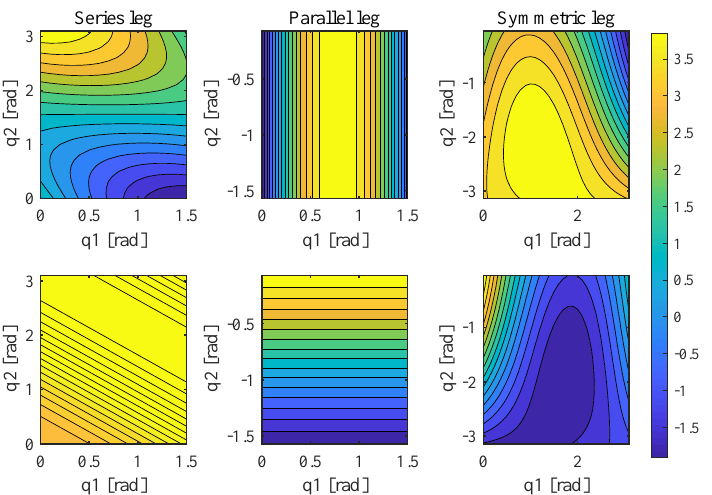
Figure 3. The proprioceptive sensing of three kinds of leg topology. The first and second line are joint 1 and joint 2 of the three types of leg, respectively; color bar represents the value (Nm) of torque of each